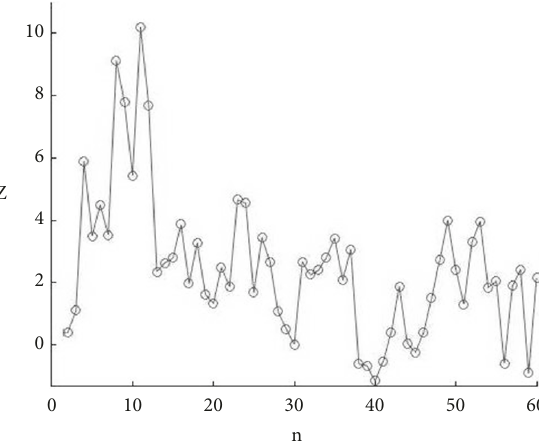
Figure 4: Graph Z (n) for the poem A.S. Pushkin “I remember a wonderful moment...”